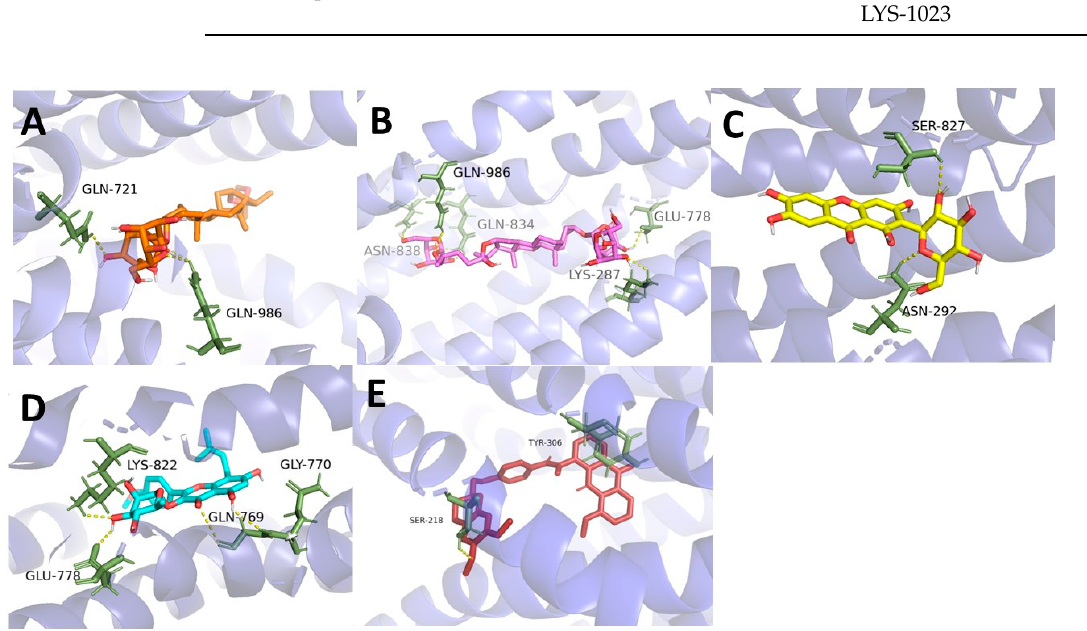
− 13.4 Molecules 2022 , 27 , x FOR PEER REVIEW